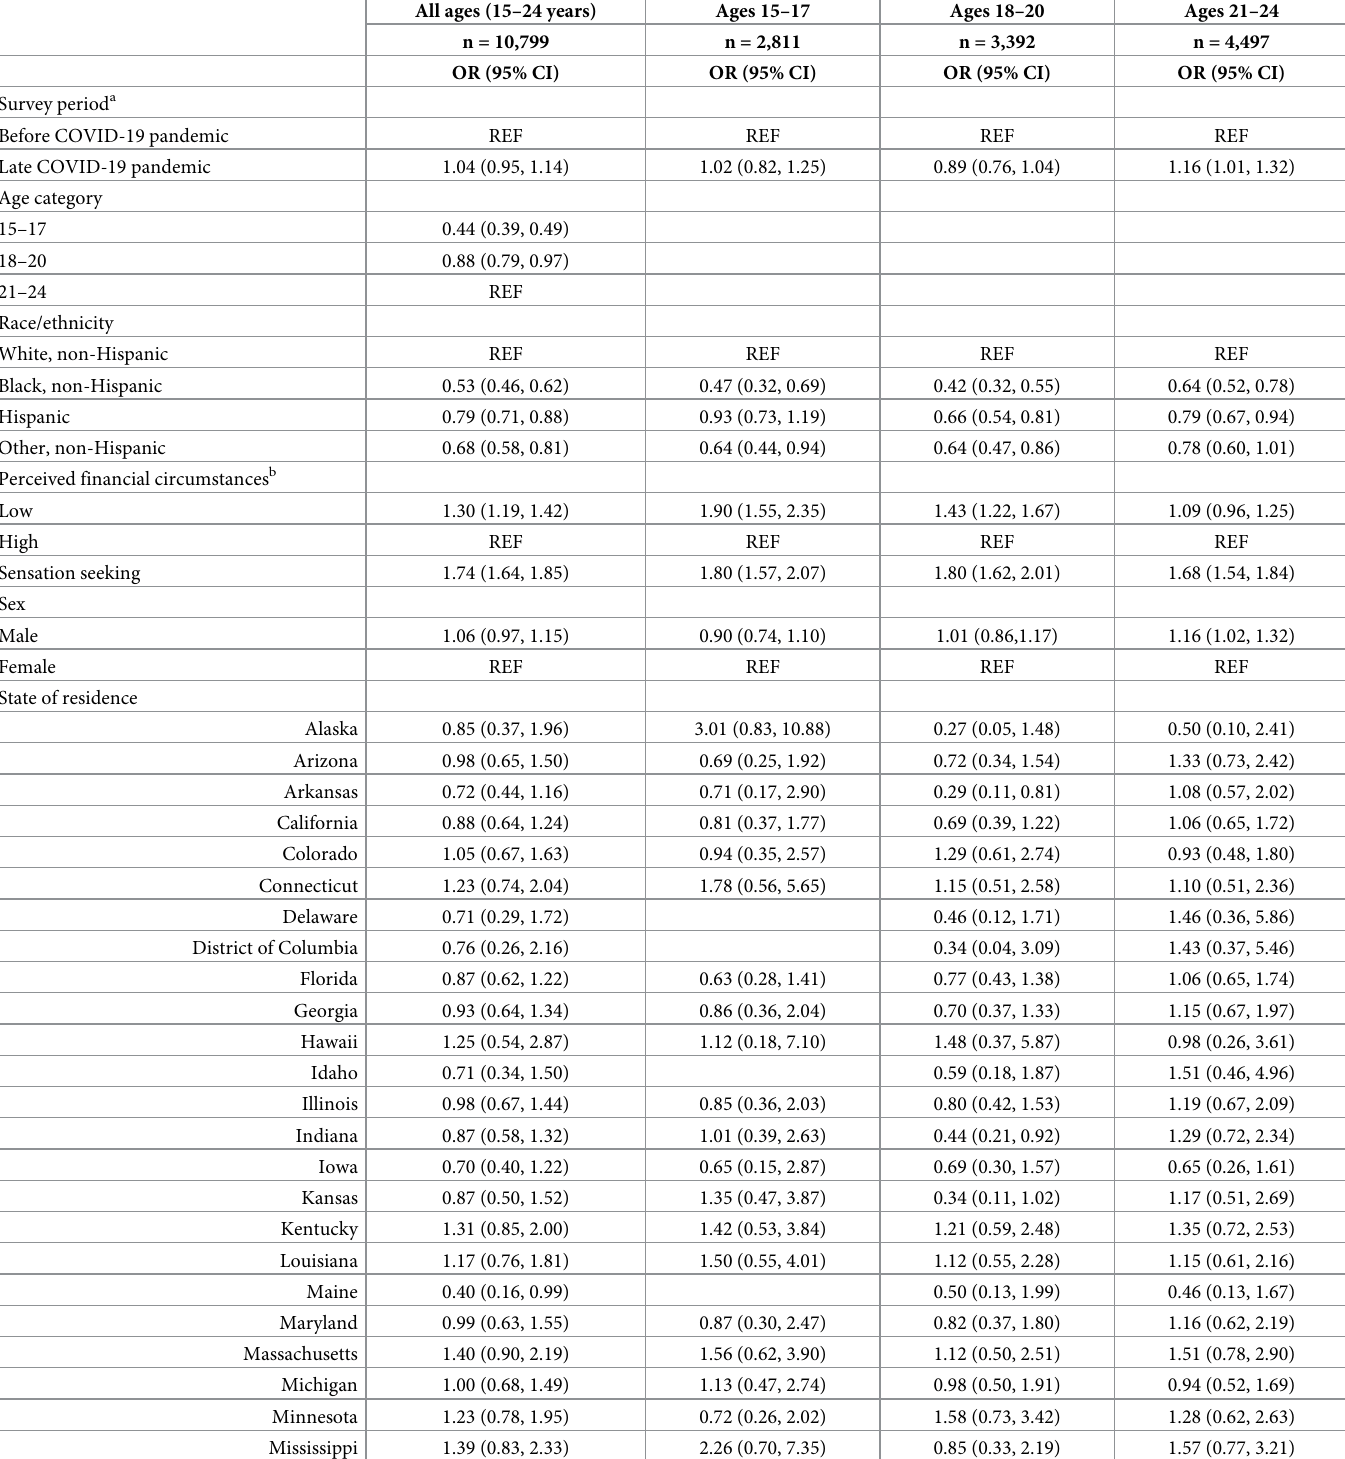
Table 3. Odds of past 30-day e-cigarette use late in the COVID-19 pandemic (August–December 2021) compared to prior to the pandemic (August–December 2019) among youth and young adults in the United States, age-adjusted or stratified by age